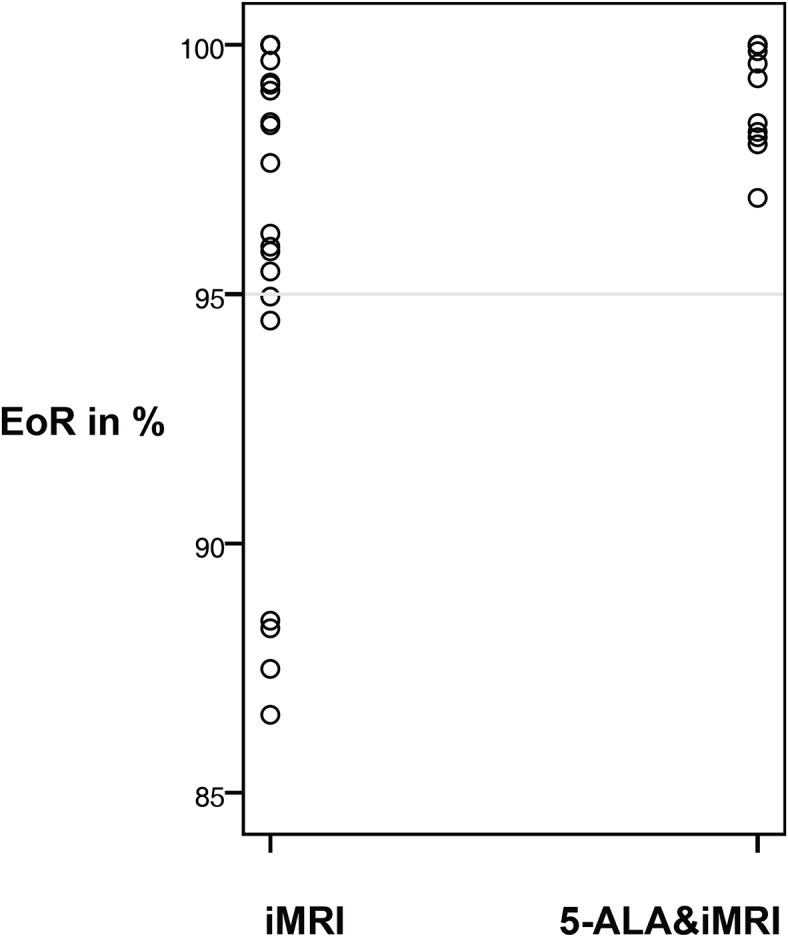
Scattered plot on extent of resection divided by iMRI group and 5-ALA&iMRI group.EoR: extent of resection, iMRI intraoperative MRI; 5-ALA: 5 Aminolevulinic acid.